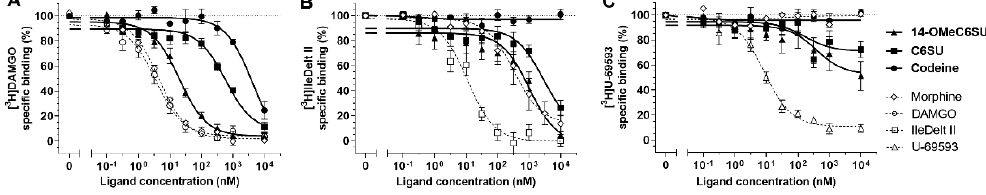
Table 1. Inhibitory constant values (K i ± S.E.M.) and selectivity ratios of codeine-6- O - sulfate (C6SU) and 14-methoxycodeine-6- O -sulfate (14-OMeC6SU) compared to codeine in competition binding assays with [ 3 H]DAMGO, [ 3 H]IleDelt II and [ 3 H]U-69593, which are μ type opioid receptor (MOR), δ type opioid receptor (DOR) and κ type opioid receptor (KOR) specific radioligands, respectively performed in rat or guinea pig brain membrane homogenates. The unlabeled form of the radioligands are also indicated for control and for further comparison. Figure 2. Dose-response curves featuring binding affinity of 14-methoxycodeine-6- O -sulfate (14-OMeC6SU) and codeine-6- O -sulfate (C6SU) to µ-opioid receptor ( A ), δ-opioid receptor ( B ) and κ-opioid receptor ( C ) compared to codeine and morphine in competition binding experiments performed in rat ( A and B ) and guinea pig ( C ) brain membrane homogenate. For control the unlabeled form of the applied radioligands are also indicated. All figures represent the specific binding of the corresponding radioligand ( A : [ 3 H]DAMGO, B: [ 3 H]Ile 5,6- deltorphin II [IleDelt II], C: [ 3 H]U-69593) in percentage (means S.E.M.) normalized to total specific binding (100%) in the presence of increasing concentrations (0.1 nM–10 μM) of the indicated unlabeled ligands. Total specific binding was determined in the absence of the indicated unlabeled ligands and indicated with a dotted line. The K i ± S.E.M. values are presented in Table 1.